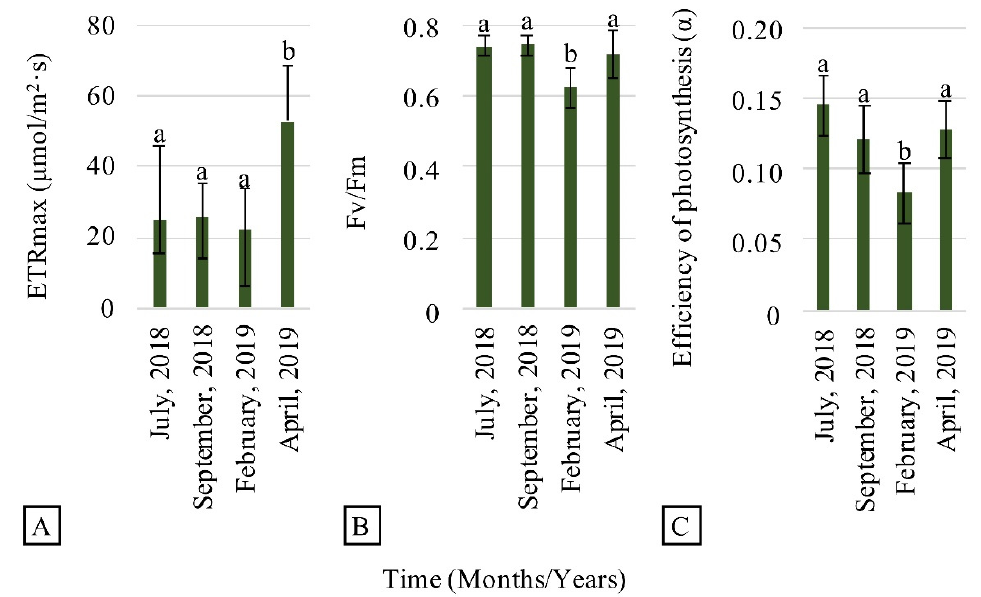
Figure 5. ( A ) Maximum electron transport rate (ETRm); ( B ) the Fv/Fm ratio and ( C ) the quantum efficiency of photosynthesis ( α ) registered for Sarcocornia perennis (mean ± SD, n = 4) for four different months of 2018 and 2019. The different letters placed on the bars show the statistically significant differences ( p < 0.05) between months.